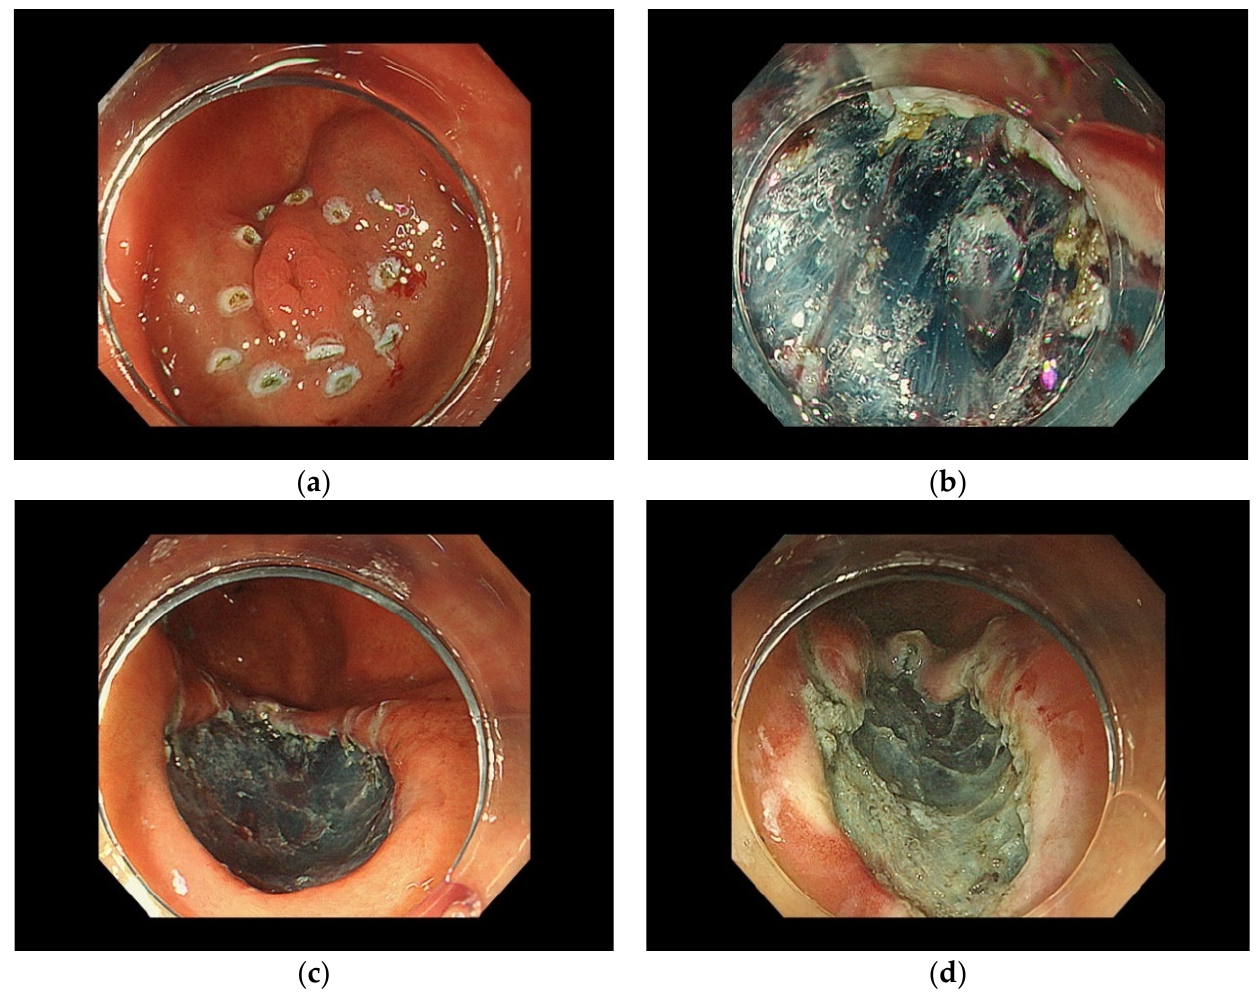
Figure 1. Method of ESD. ( a ) Markings located outside the horizontal margin of the lesion. ( b ) Submucosal tissue dissection beneath the lesion. ( c ) Endoscopic complete resection. ( d ) The defect after coagulation of visible vessels remaining in the resection area.